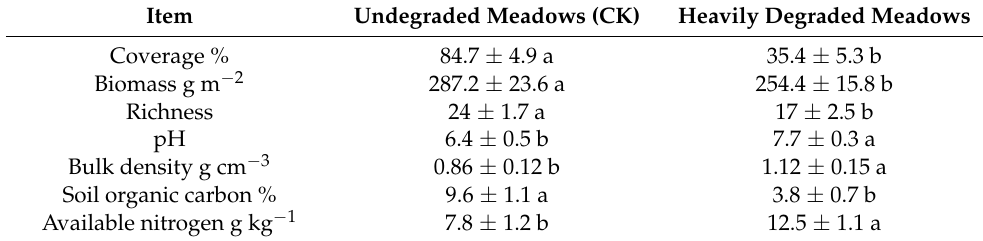
Table 1. Plant and soil physical characteristic in heavily grazed and native alpine meadows. Item Undegraded Meadows